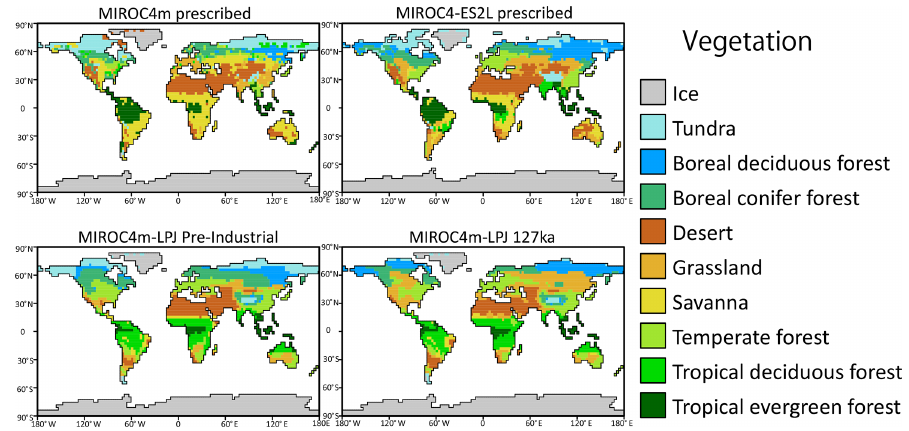
Figure 3. Vegetation distribution as a fixed boundary condition (MIROC4m and MIROC-ES2L) and the resultant most dominant vegetation types in MIROC4m-LPJ experiments in PI and 127k. Table 2. List of